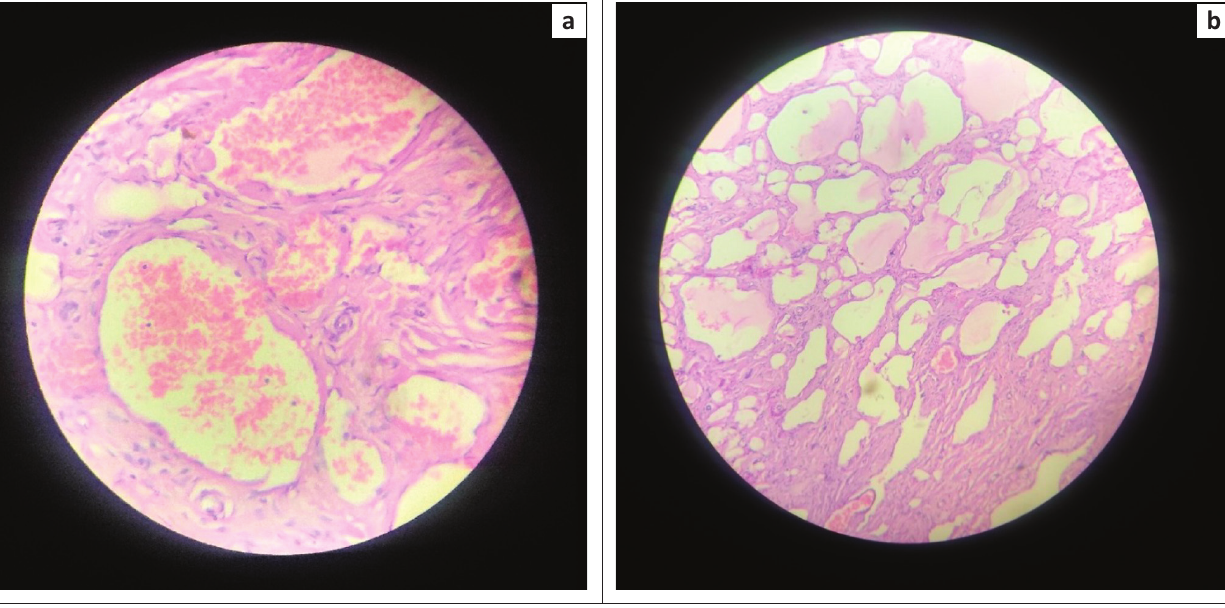
FIGURE 6: Post-operative histopathological slides of the mass with haematoxylin and eosin staining (a) and (b) show large, blood-filled cavernous vascular spaces separated by connective tissue stroma typical of cavernous